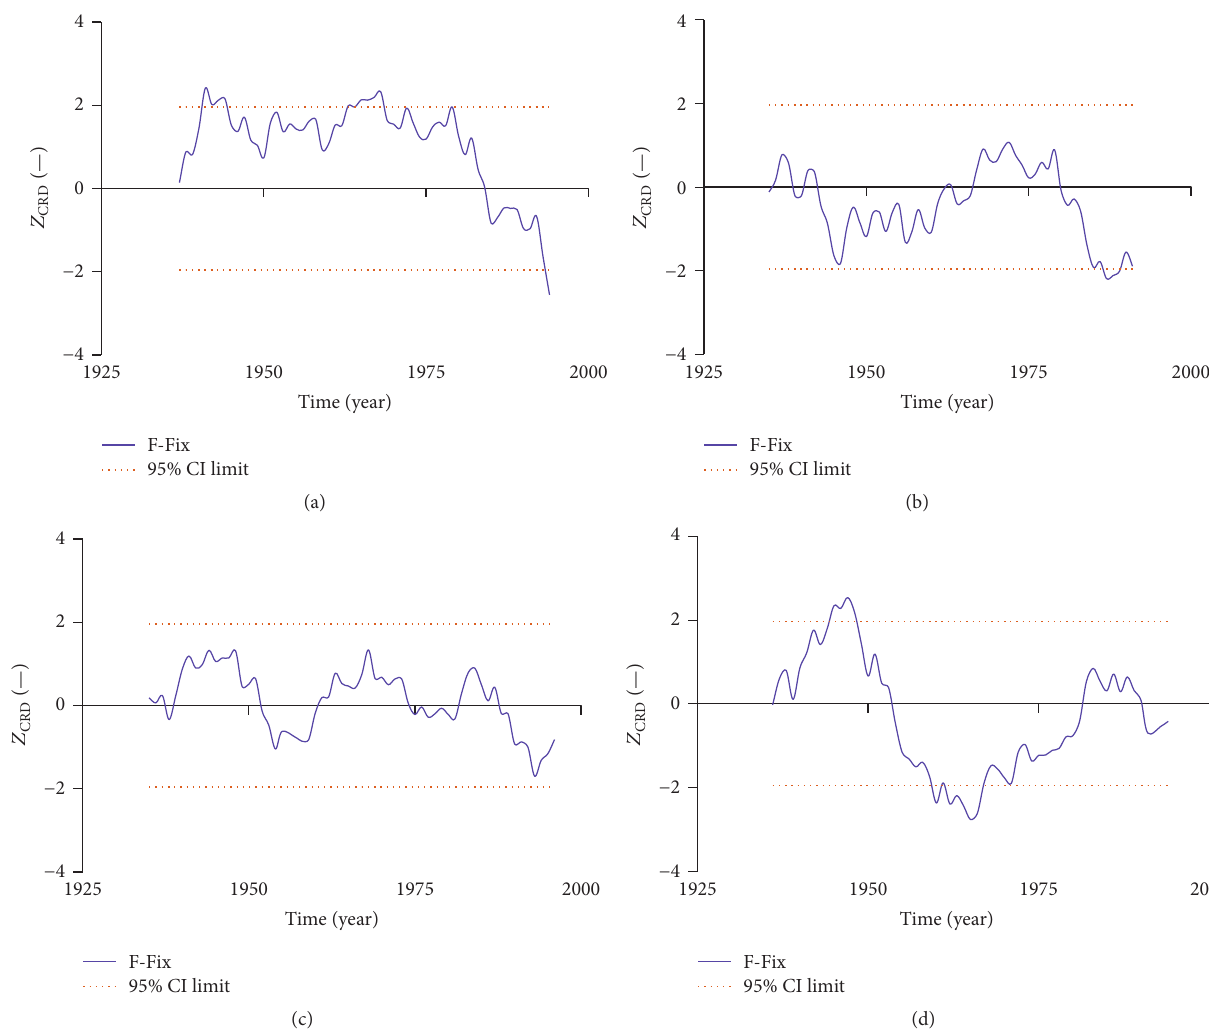
Figure 4: Trend evolutions obtained using forward moving window of fixed time frame moved in forward (F-Fix) way based on the annual rainfall at station: (a) 4, (b) 10, (c) 12, and (d)